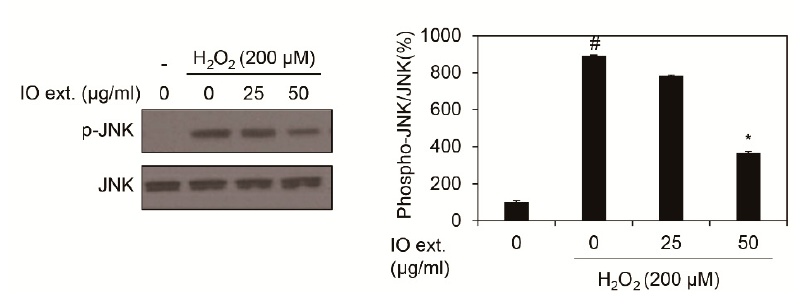
Figure 4. Effects of extracts of Inonotus obliquus on JNK phosphorylation in human dermal fibroblasts. JNK and p-JNK protein expression were assessed by using Western blot assay. β -Actin served as an internal control, and different concentrations of Inonotus obliquus extracts (0, 25, and 50 μ g/mL) were treated in human dermal fibroblasts. JNK band density was measured by Image J software and normalized by band density of p-JNK. The graphs are expressed as the mean ± S.D. from triplicate experiments. # p < 0.05 compared with non-treated cells. * p < 0.05 compared with 200 µ M H 2 O 2 -treated cells.